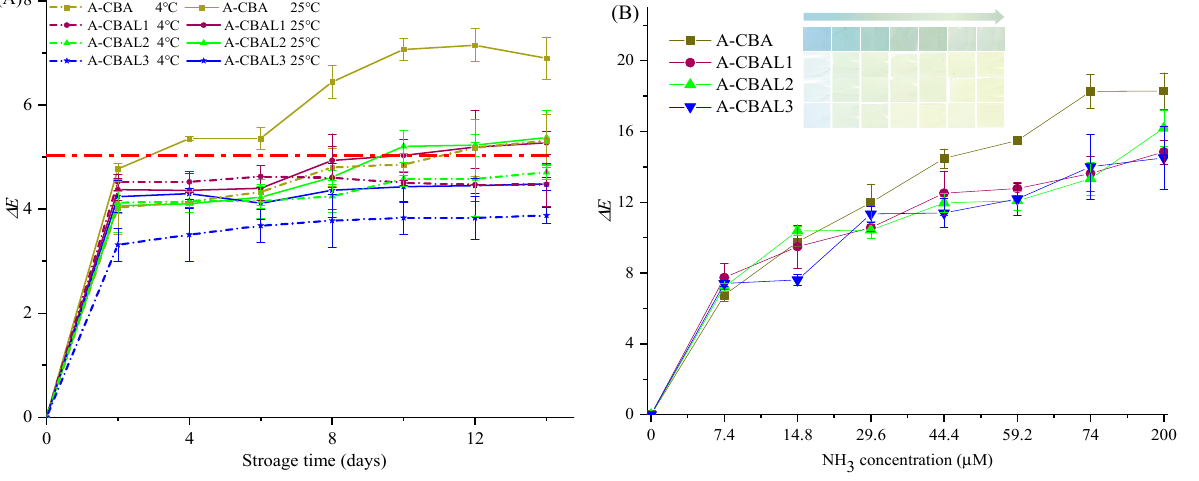
Figure 5. Color changes of the films stored at 4 °C ( A ) and 20 ℃ (B) for 20 d.